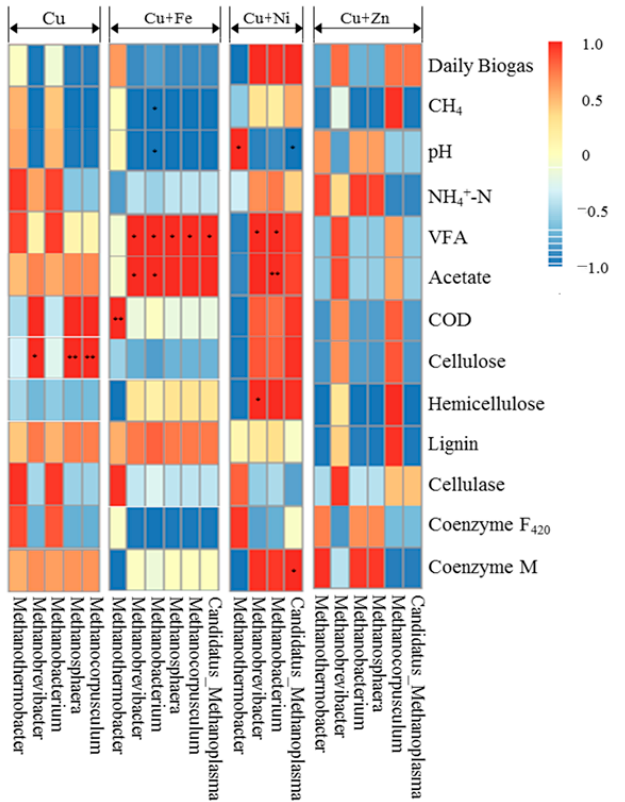
Figure 9. Pearson correlations between methanogens and fermentation parameters (*, p < 0.05; **, p < 0.01). NH 4 + -N, ammonia nitrogen; COD, chemical oxygen demands; VFA, volatile fatty acids. Different colors represent the correlation coefficients from − 1 (blue) to 1 (red) as shown in the right.